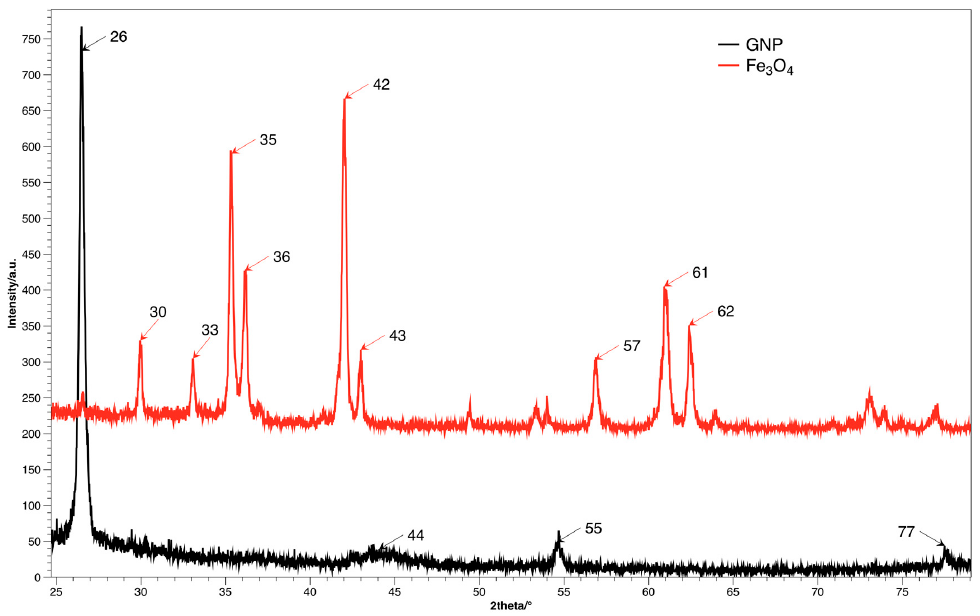
Figure 4. XRD diffractogram for fillers.